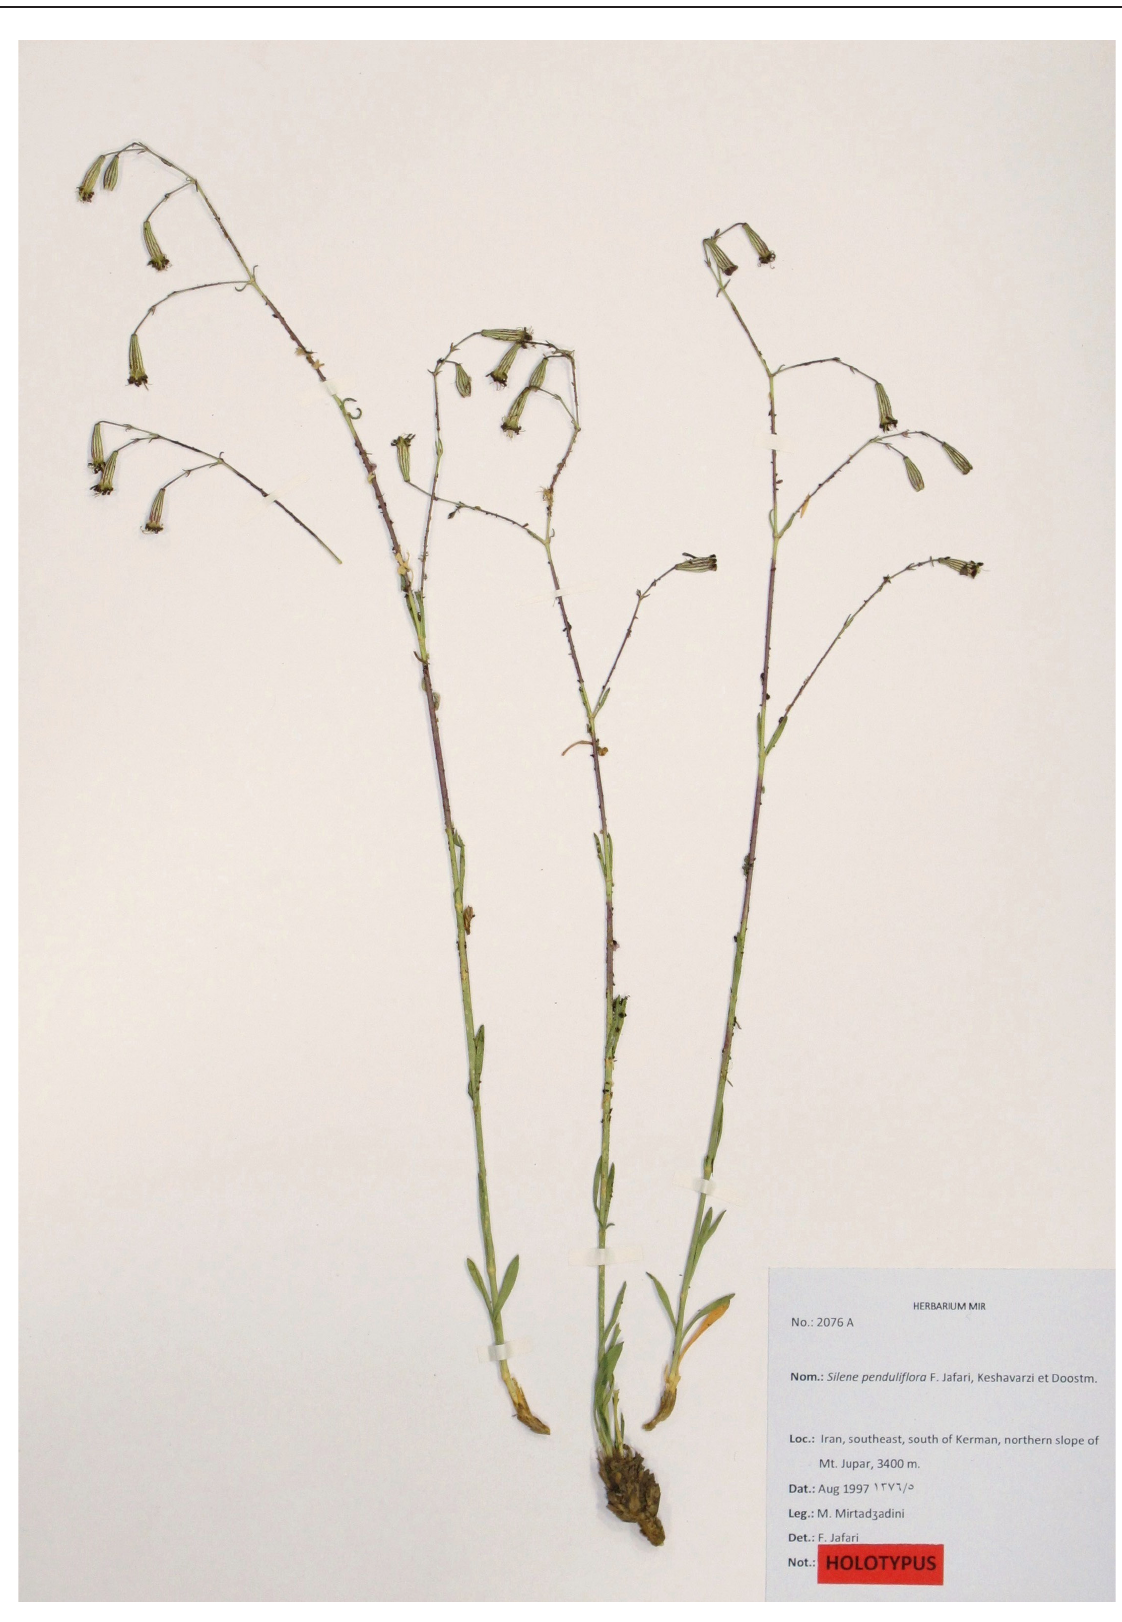
Fig. 7. Silene penduliflora F.Jafari, Keshavarzi & Doostm. sp. nov. (holotype, M. Mirtadzadini 2076 ;